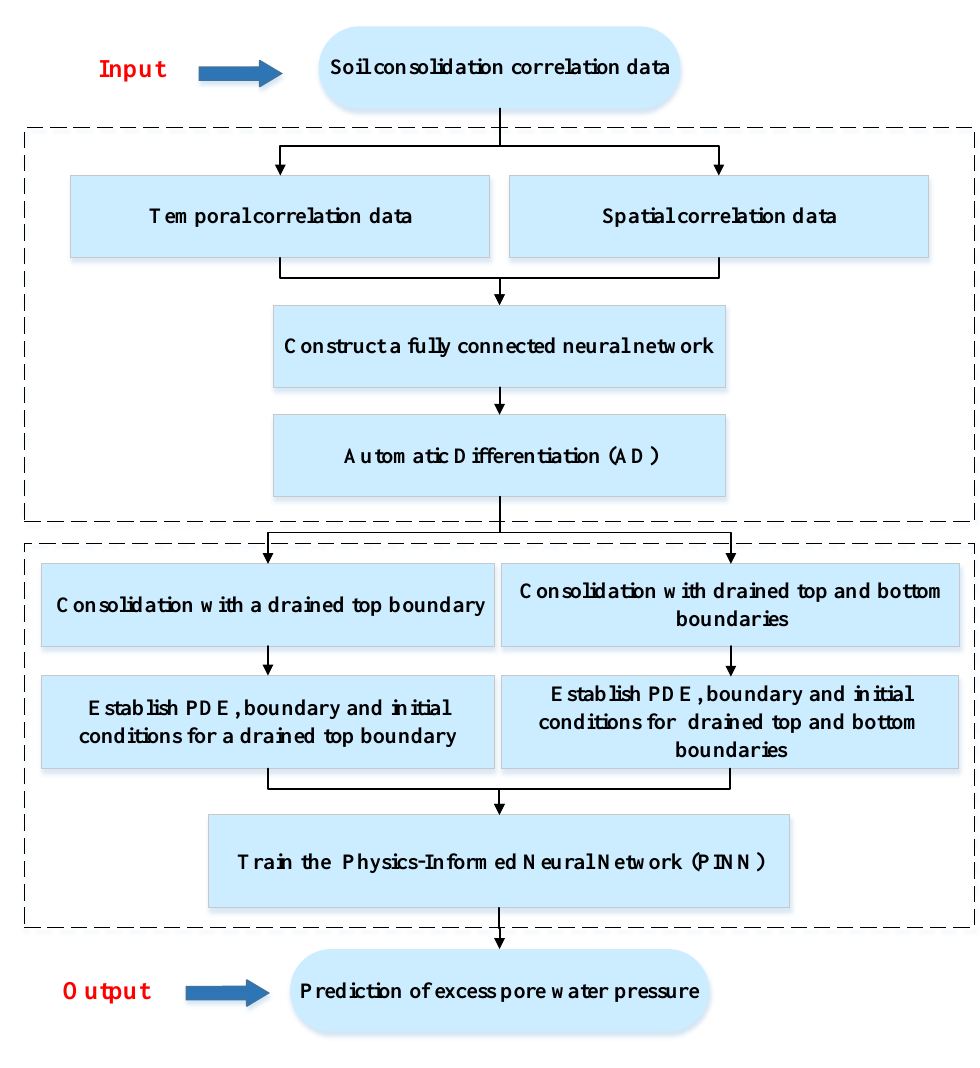
Figure 1. Flowchart of the proposed deep learning